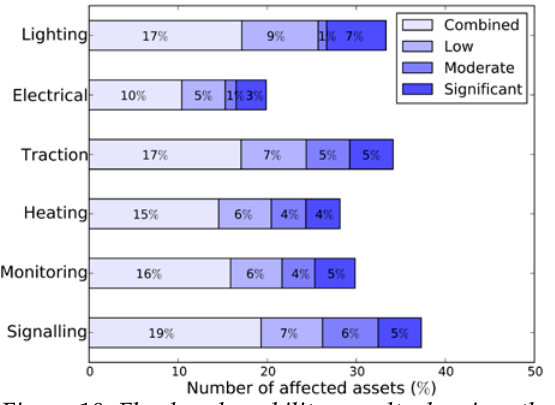
Figure 11. Flood vulnerability result showing the percentages of disrupted passengers for different type of flood likelihood